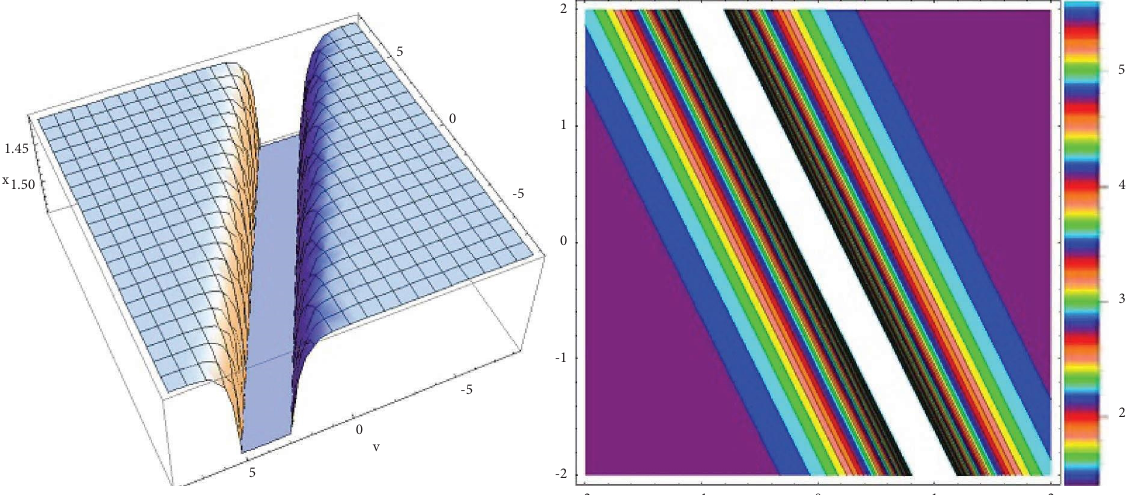
Figure 18: Singular bell type soliton sketching from (47) for � 2.